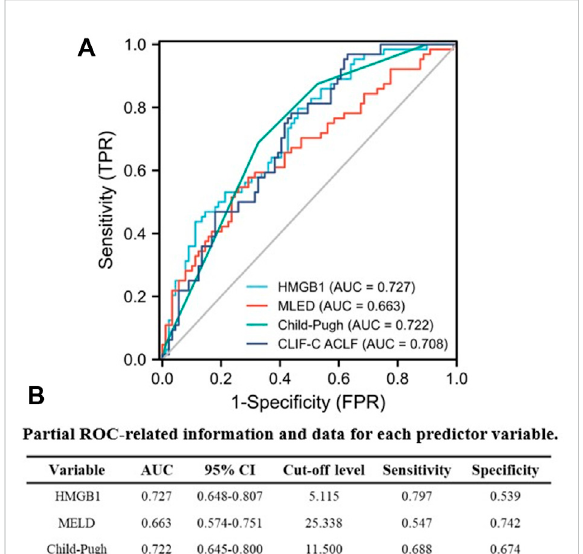
FIGURE 5 Performance of serum HMGB1 level, MELD, Child-Pugh and CLIF-C ACLF scores were compared in predicting 90-day adverse outcomesinAKIpatientsusingAUROC (A) . (B) Partial ROC-related information and data for each predictor variable (AUROC, area under the receiver operating characteristic curve; AKI, acute kidneyinjury;HMGB1,high-mobilitygroupbox1;MELD,modelfor end-stage liver disease; Child-Pugh, Child-Turcotte-Pugh; CLIF- C ACLF; CLIF-Consortium